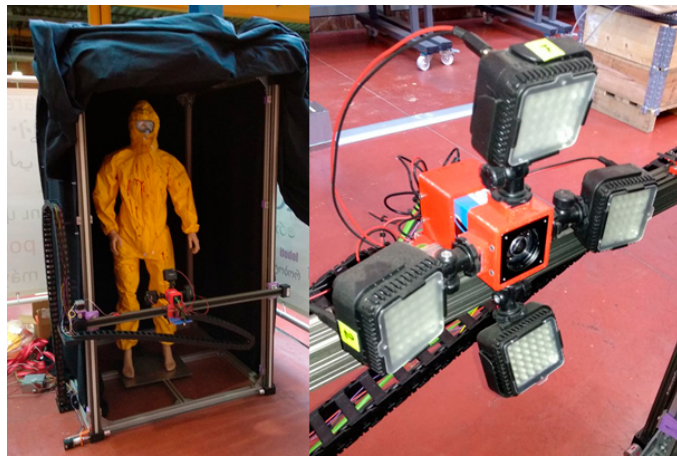
Figure 1. HORUS full-body scanner structure: ( left ) Overall mechanism view and ( right ) illumination system composed of a motorized camera DFK Z12G445 and 4 Neewer CN-Lux260